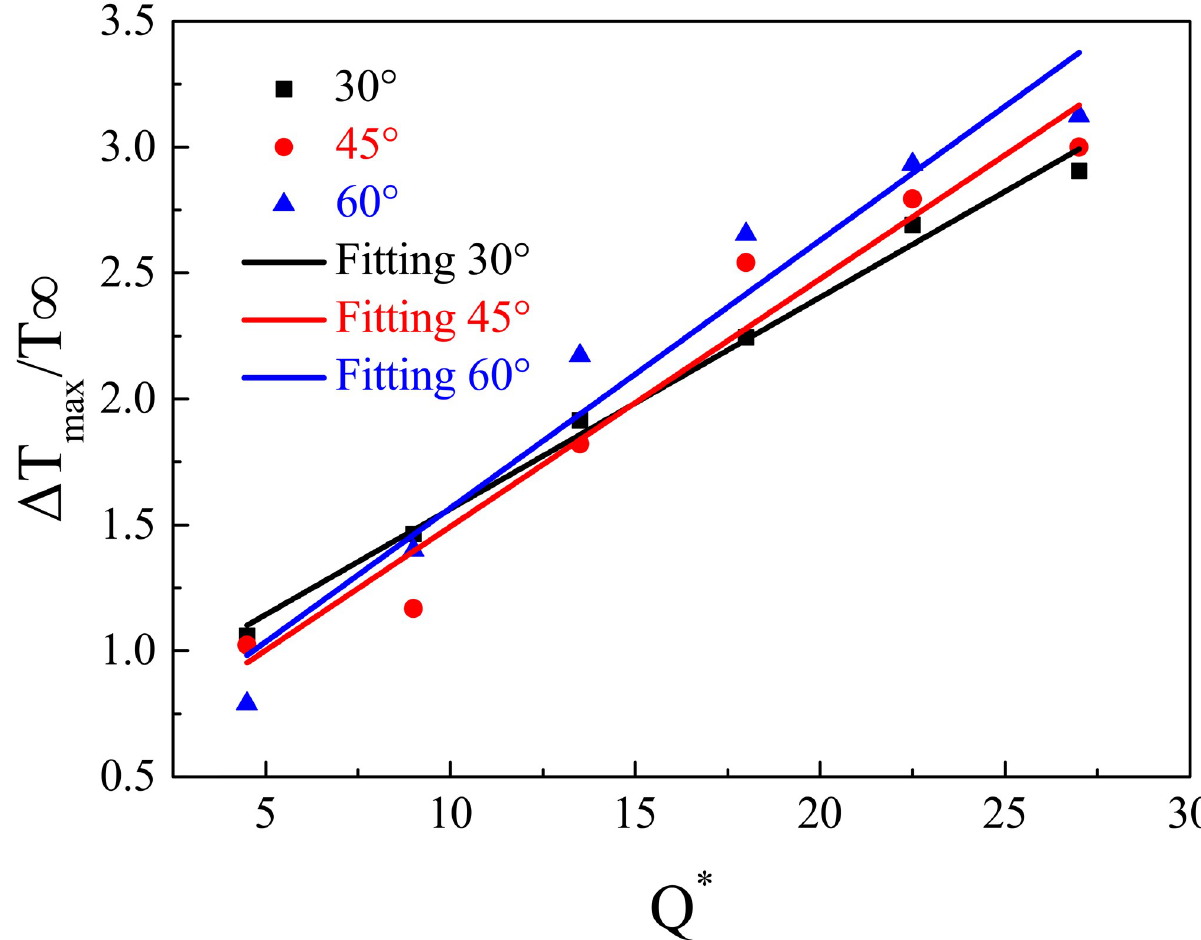
Fig 8. Δ T max / T 1 against Q � for various bifurcation angles.